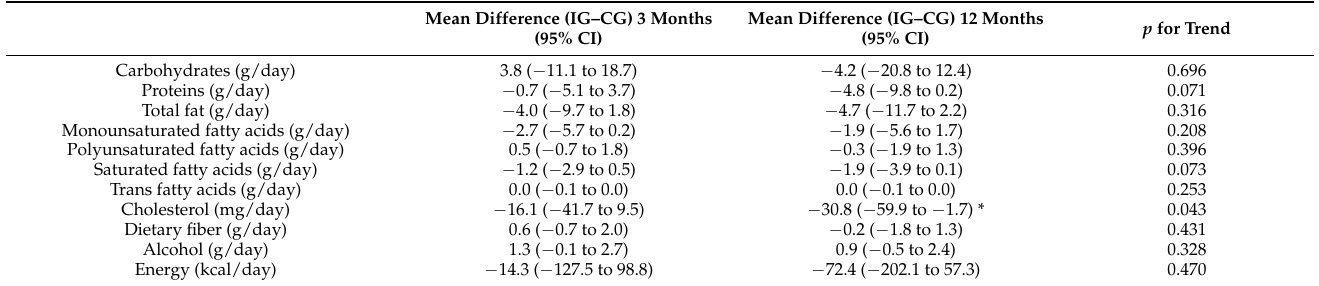
Figure 4. Evolution of the intake of macronutrients throughout the study.